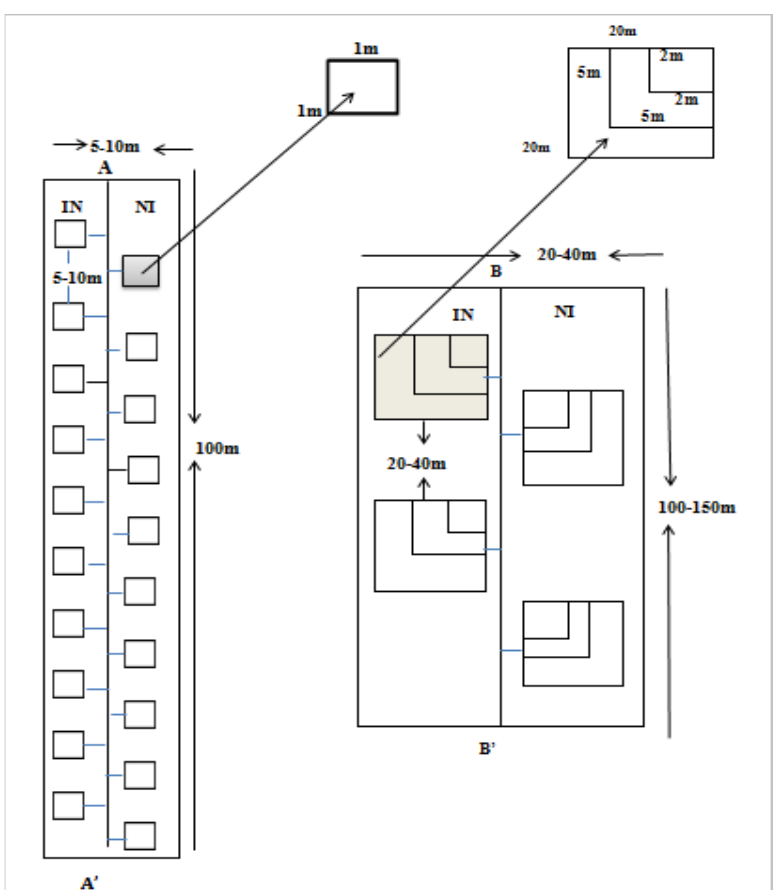
Figure 2. Layout of sample plots for vegetation data collection in different land use types. Notes :— Transect A–A’ shows layout for herbaceous vegetation data collection in agricultural land, roadside, and grassland land use types (10 similar layouts of transects were laid in each site). Transect B–B’ indicates layout for vegetation data collection in woodland land use types (five similar layout tran- sects were laid in each